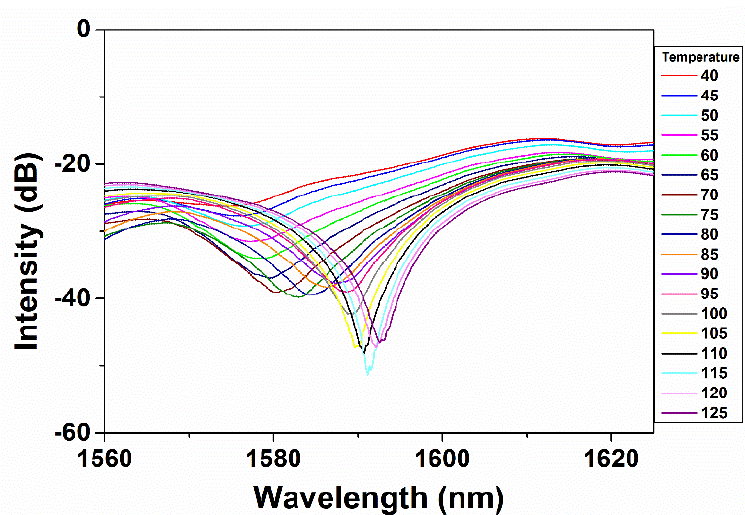
Figure 3. The relationship between interference dip wavelength shifting and the continuous temperature change from 40 to 125 °C at an interval of 5 °C.